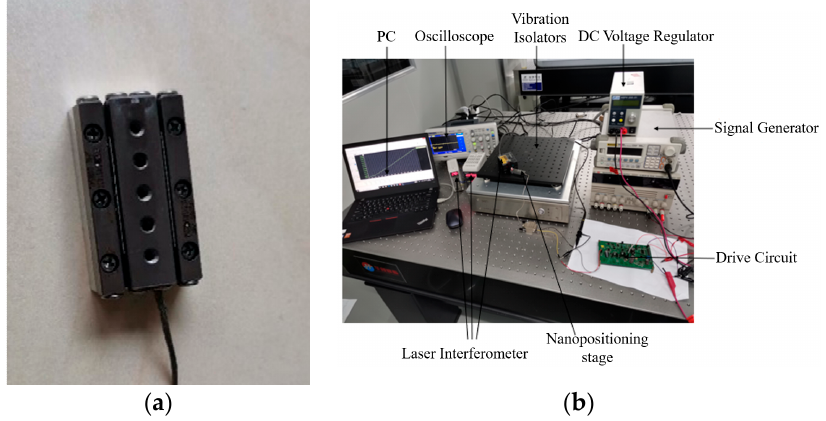
Figure 12. ( a ) Constructed stage and ( b ) experimental system for performance measurement.